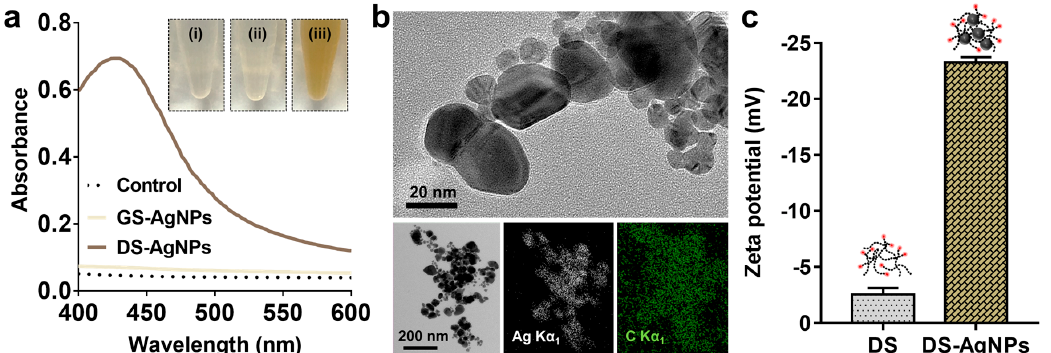
Figure 2. ( a ) UV-vis absorption spectra showing the absorption band of AgNPs formed without (control) and with 1 mg/mL of gelatinized starch (GS-AgNPs) or debranched short-chain glucans (SCG) (DS-AgNPs) under 5 min UV irradiation. Inset shows the photographic images of the corresponding reaction solution of control (i), GS-AgNPs (ii), and DS-AgNPs (iii). ( b ) Transmission electron microscopy (TEM) image (top) and element mapping analysis (bottom) of AgNPs formed with debranched SCG (1 mg/mL). Silver (Ag) and carbon (C) are represented in white and green, respectively. ( c ) Zeta potential of debranched starch (DS) and DS-AgNPs.